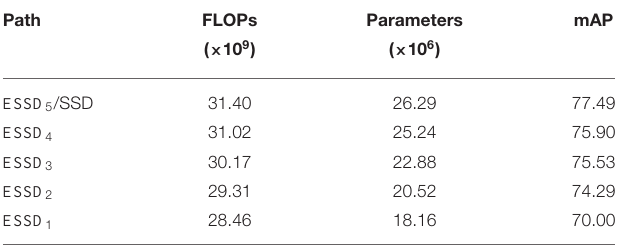
TABLE 2 | Comparison of FLOP counts, parameter counts, and mAP levels for different paths in the trained ESNO system with pruning disabled.